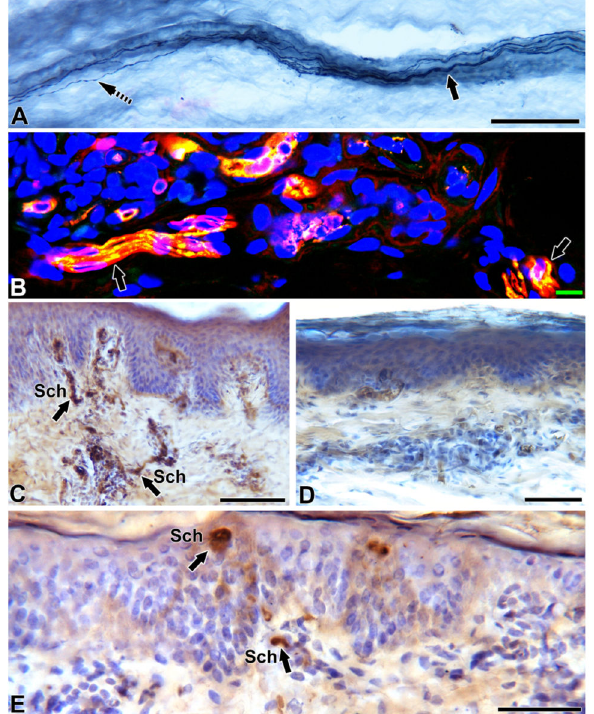
Figure 4. Schwann cell staining (p75) and confocal microscopy triple staining with PGP9.5, GAP43 and DraQ5 at the junction between native skin and alloflap. Skin sections immunostained with PGP9.5 (A), nerve growth factor receptor, p75 (C, D and E) and confocal microscopy montage triple-stained with the axonal marker PGP9.5 (red), GAP 43 (green) indicating co-localization as yellow and the nuclear marker DraQ 5 (blue).